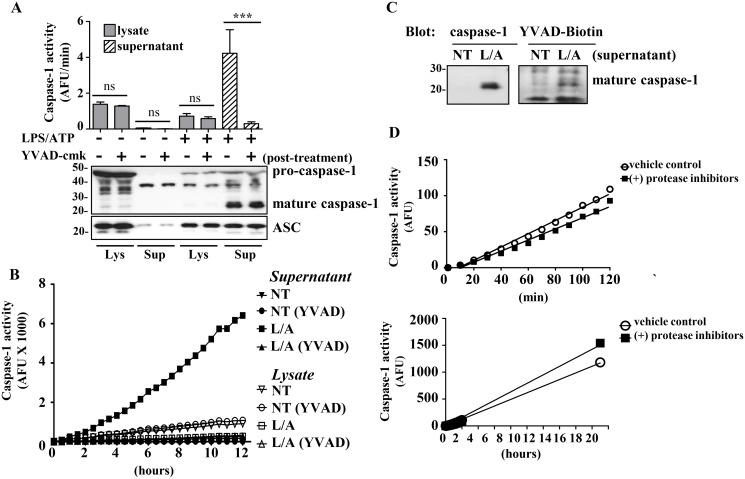
Active caspase 1 is released from THP1 cells upon LPS/ATP stimulation.A) WEHD-afc cleavage in untreated or LPS/ATP treated cell lysates and supernatant (2x107 cells/ml) in the presence or absence of YVAD-cmk inhibitor (50 μM). Caspase-1 presence in samples was verified by Western blotting. ASC used as a loading control (bottom). B) Caspase-1 activity in untreated (NT) and LPS/ATP treated cell lysates and supernatants in the presence or absence of YVAD-cmk inhibitor (50 μM) over the course of 12h. Closed symbols indicate supernatant fractions, open symbols indicate lysate fractions. C) Biotin-YVAD-cmk (50 μM) labeling of mature caspase-1. Supernatants from THP1 cells left untreated (NT) or stimulated with LPS/ATP (L/A) were incubated with biotin-YVAD-cmk. Western blot for caspase-1 is shown on the left, and Vectastain blot for biotinylated proteins on the right. D) Supernatants from LPS/ATP treated THP1 cells supernatant (2x107 cells/ml) were incubated with complete protease inhibitor cocktail or vehicle controls and activity was measured over 2h and overnight. Representative gels and data expressed as mean ± SEM from n = 3 independent experiments (A: ANOVA with Tukey Multiple Comparison test: ***p<0.0003). Representative time course from n = 3 independent experiments (B) and representative Vectastain blot from n = 3 experiments (C). Mean of n = 2 independent experiments (D).